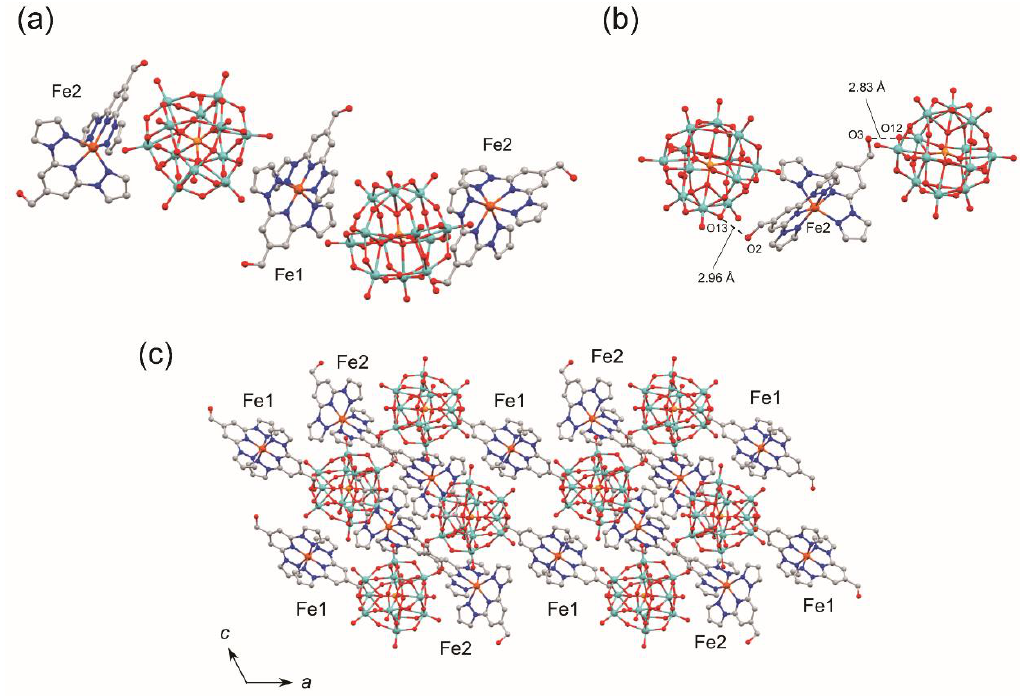
Figure 3. ( a ) X-ray structure of 2 ; ( b ) hydrogen bonding interactions between Fe2-complexes and [PMo 12 O 40 ] 3− and ( c ) the packing structure of 2 viewed along the crystallographic b -axis. Color code: C: gray, N: blue, O: red, P: orange, Fe: brown, Mo: light blue (hydrogen atoms and solvent molecules omitted for clarity).